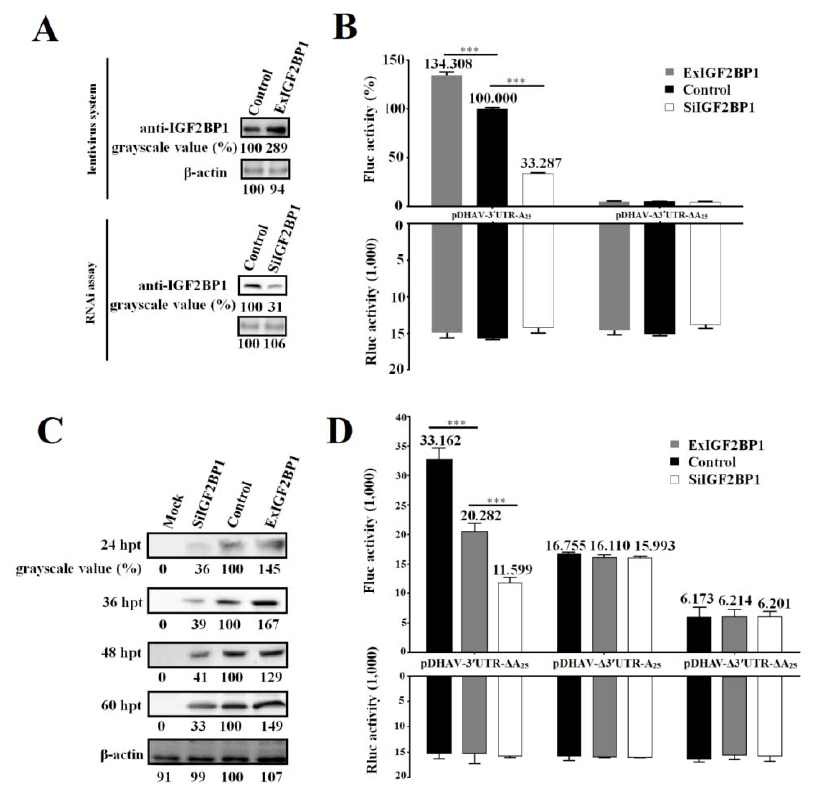
Figure 3. IGF2BP1 strongly enhances DHAV-1 internal ribosome entry site (IRES)-mediated translation e ffi ciency via binding to 3 (cid:48) UTR. ( A ) The IGF2BP1 expression level in ExIGF2BP1 duck embryo epithelial (DEE) and SiIGF2BP1 DEE cells was tested by western blot assay with anti-IGF2BP1 antibody. ( B ) The same quantity (0.8 µ g) of the in vitro transcribed products of linearized plasmids pDHAV-3 (cid:48) UTR-A 25 and pDHAV- ∆ 3 (cid:48) UTR- ∆ A 25 was transfected into the ExIGF2BP1 DEE, SiIGF2BP1 DEE, and normal DEE cells, and the luciferase activities were detected at 4 hpt. Reporter RNA of pRluc was transfected into the DEE cell line as the control. The FLuc activity of pDHAV-3 (cid:48) UTR-A 25 in the normal DEE cell line was set as 100%. ( C ) The RNA-launched infectious clone pR-DHAV-1 was transfected into the ExIGF2BP1 DEE, SiIGF2BP1 DEE, and normal DEE cells, and the cell lysates were collected from 24 hpt to 60 hpt for western blot analysis with anti-DHAV-1 mAb 4F8. The grayscale value of the normal DEE cells was set as 100%. Columns and bars represent means of three independent transfections and standard deviations. ( D ) The same quantity (0.8 µ g) of the in vitro transcribed products of linearized plasmids pDHAV-3 (cid:48) UTR- ∆ A 25 , pDHAV- ∆ 3 (cid:48) UTR-A 25 , and pDHAV- ∆ 3 (cid:48) UTR- ∆ A 25 were transfected into the ExIGF2BP1 DEE, siIGF2BP1 DEE, and normal DEE cells, respectively, and the FLuc activity